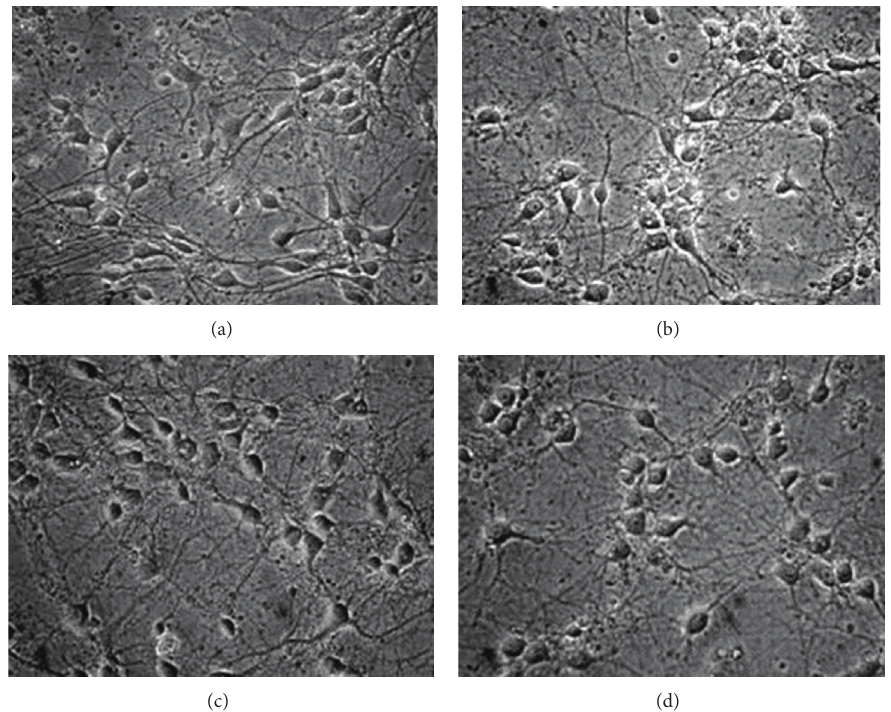
Figure 3: Morphology of the primary cortical neurons in culture (400X). (a) Control, (b) Neurons without any treatment for 3 days then exposed to 100 𝜇 M/L-CoCl 2 for 12 hours. (c) Neurons irradiated for 80 seconds in the dark with 25mW/cm 2 808 nm LED light, once a day for 3 days, then exposed to 100 𝜇 M/L-CoCl 2 for 12 hours. (d) Neurons were irradiated by 25 mW/cm 2 808 nm LED light for 3 days then exposed for 12 hours without 100 𝜇 M/L-CoCl 2 treatment. Images shown are representative of several plates for each group.